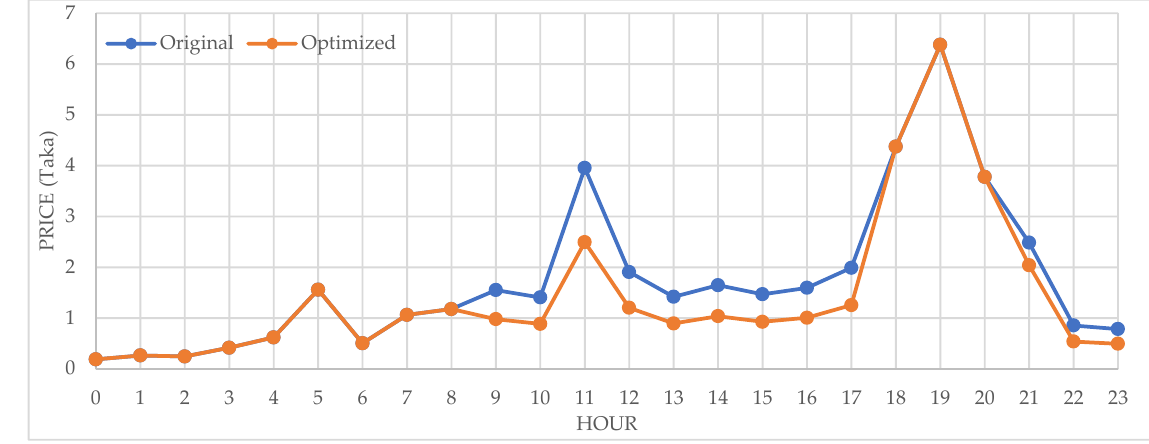
Figure 11. Reduction of utility bills . Table 3 indicates that the consumer deducts 17.54% of the electric bill on a typical day in July. The interaction with the grid has been also reduced by 49.53%. Table 3. Comparison between original exchange and modified exchange with the grid in a typical day .